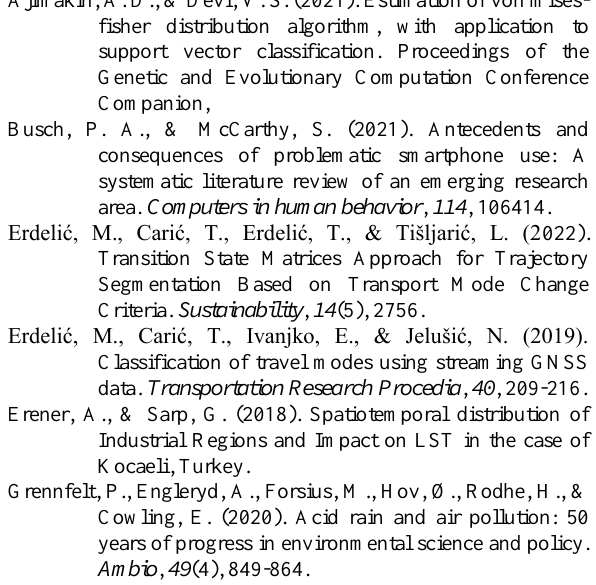
In addition to the confusion matrices, precision, recall, and F1- score are the metrics used to evaluate the performance of models, as shown in Table 3.